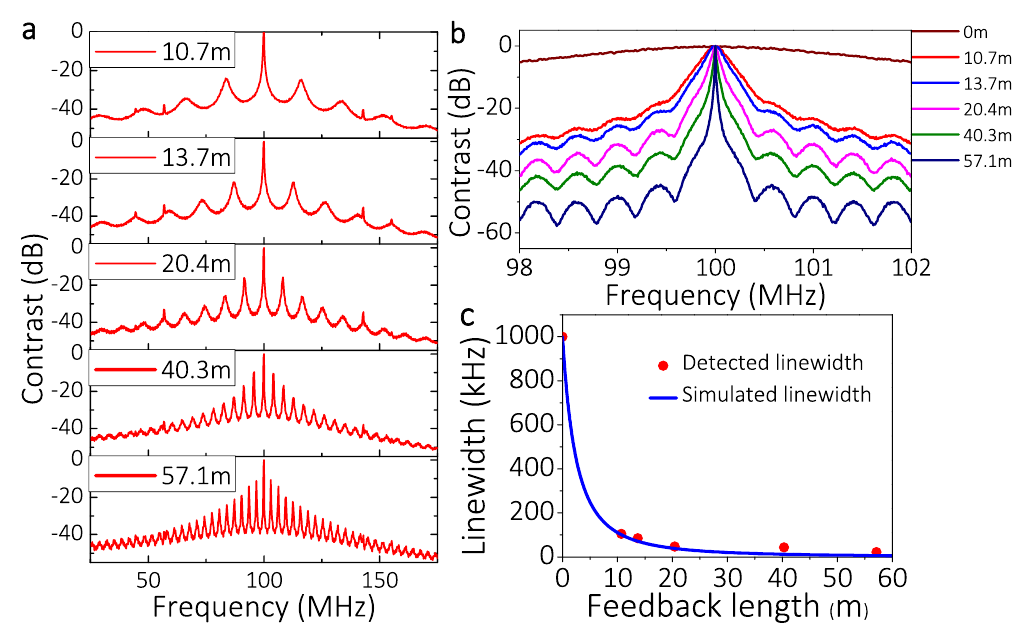
Figure 3. ( a , b ) Normalized power spectra for different feedback lengths with single-cavity feedback. ( c ) Corresponding fitting linewidth from ( b ) (red points) and the simulated linewidth for different feedback length (blue curve) with Δ f 0 = 1 MHz, τ in = 0.0534 ns, α = 5, γ = 0.0008 (~31 dB isolation of DFB isolator), R in = 0.9, Re = 0.1, ε =